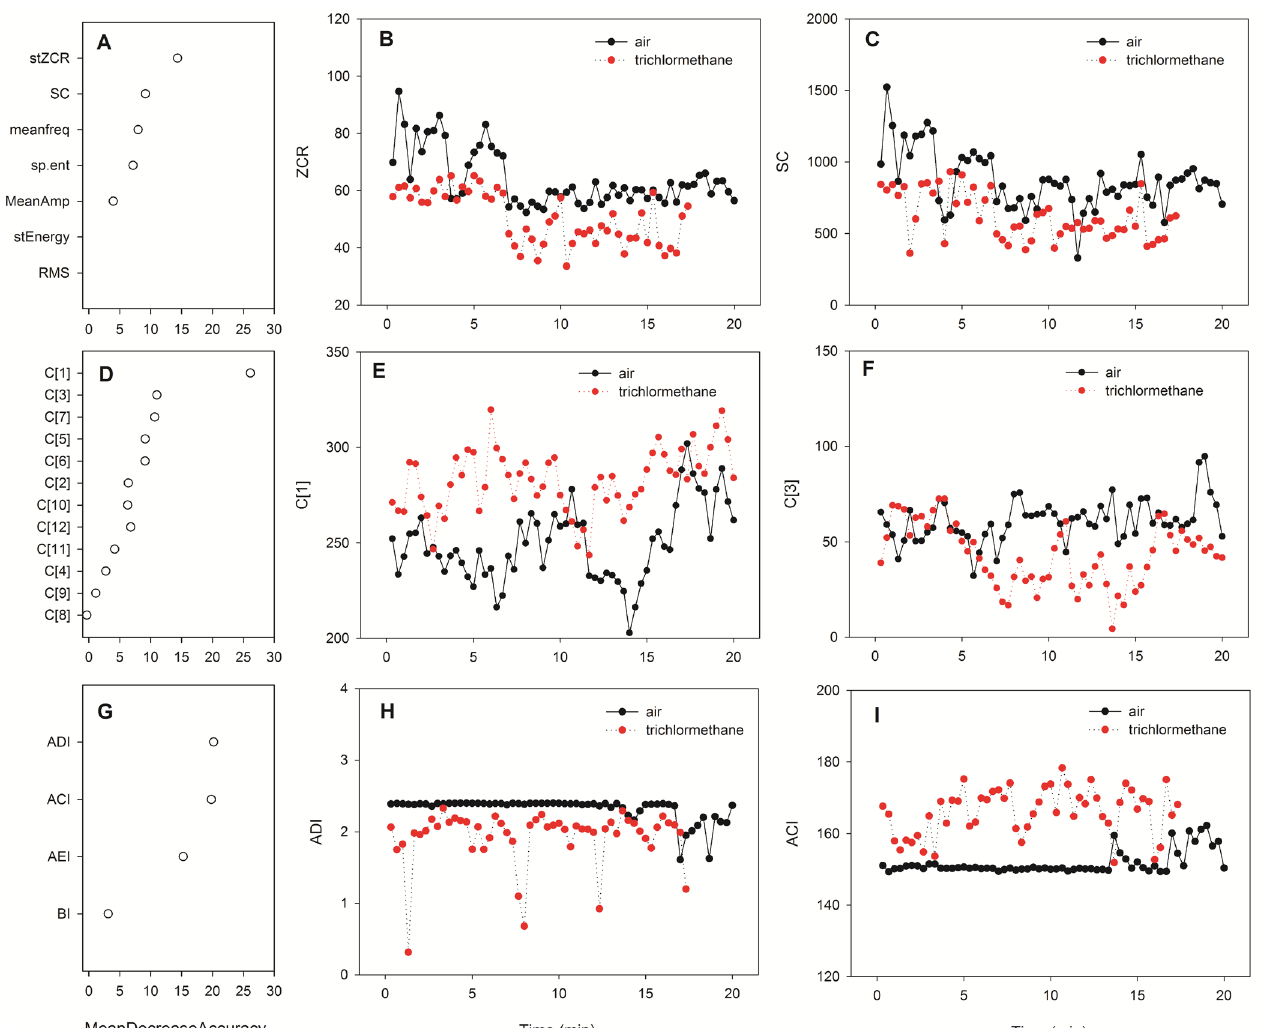
Fig 1. The importance order of three feature sets and their changes with time. Black circles denotes ventilating blank air, red circles denotes trichloromethane-laced air. Each point represents the datum extracted from a 20-s audio sample. CZR: Zero- Crossing Rate, CS: Spectral Centroid, C[1] to C[12]: MFCC Coefficients, sp.ent: Spectral Entropy, meanfreq: mean frequency, meanAmp: mean amplitude, Energy: energy of singal, RMS: root-mean-square level, ACI: Acoustic Complexity Index,